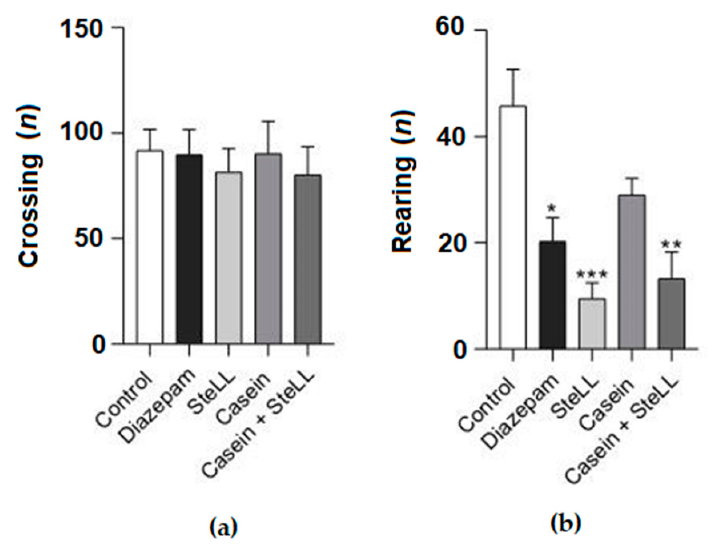
Figure 4. The incubation of the lectin with casein did not revert the anxiolytic effect of SteLL (4 mg/kg) in the open field test. ( a ) Total number of crossings. ( b ) Total number of rearings. (*) p < 0.05; (**) p < 0.001; (***) p < 0.0001 compared to control.